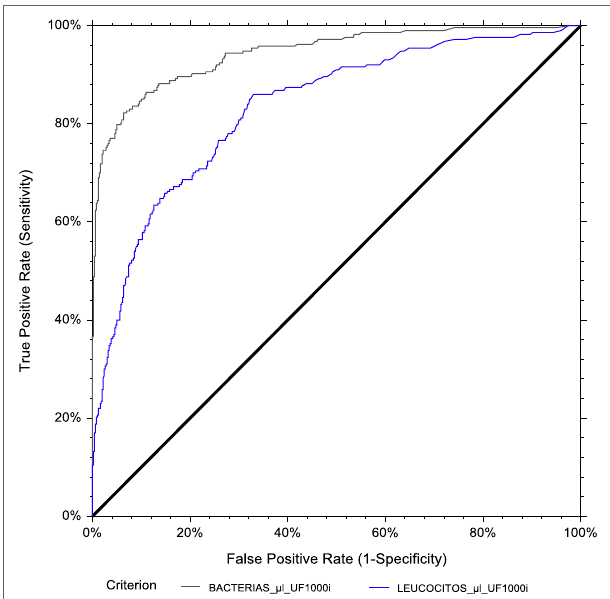
FIgURe 10 | ROC curve analysis for general population. The area under the curve (AUC) is 0.943 for bacterial count and 0.832 for leukocyte count by flow cytometry, using urine culture as the reference method.